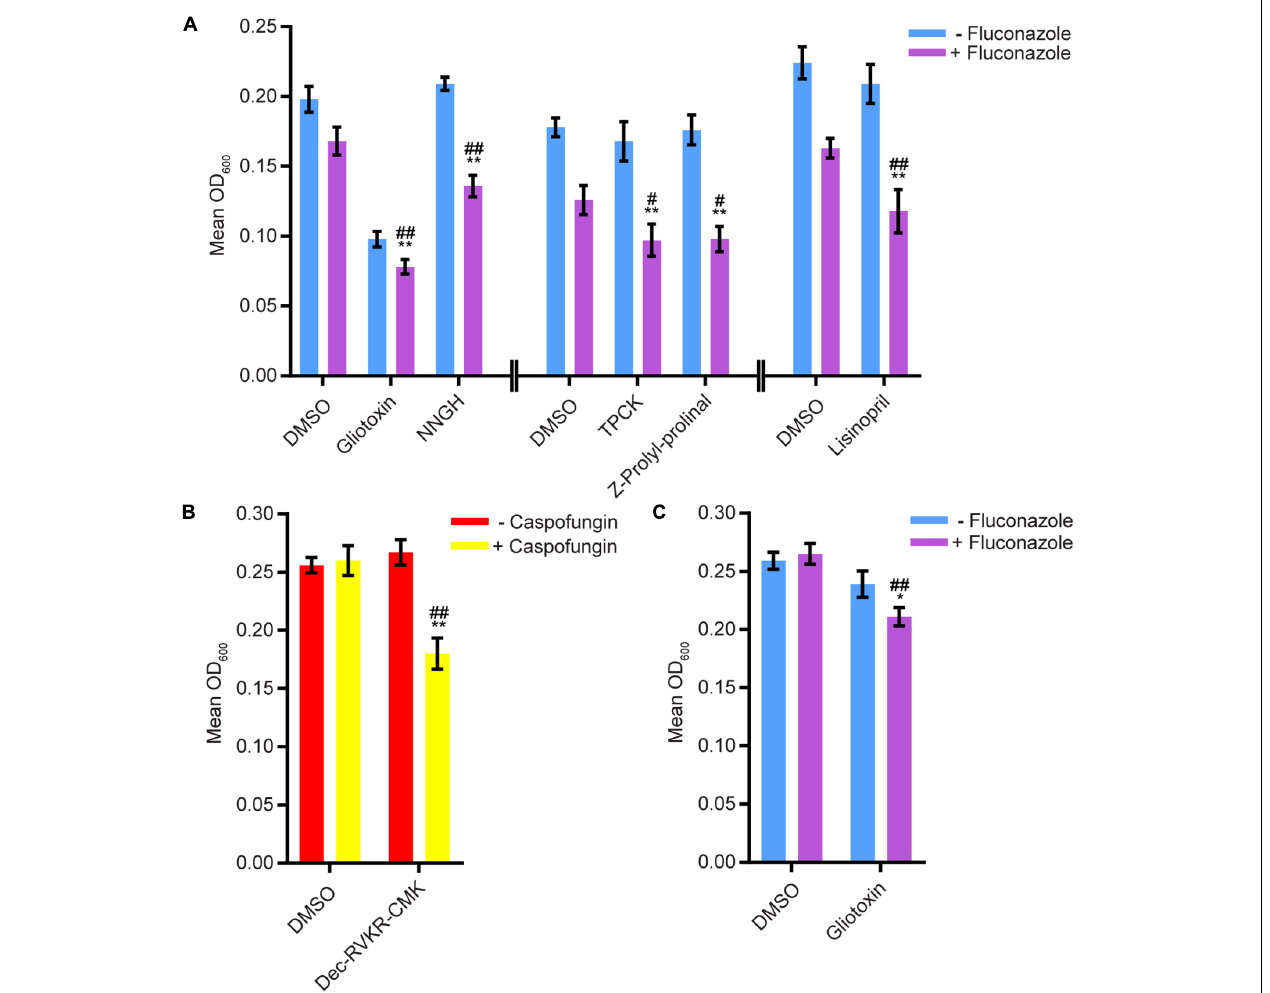
FIGURE 2 | Six compounds from the SCREEN-WELL R (cid:13) Protease Inhibitor Library either inhibited biofilm formation or disrupted mature biofilms in combination with one or more antifungal agents. (A) Statistically significant hits from the combination Sustained Inhibition Biofilm Assays with fluconazole. For each compound, the wells with fluconazole (+fluconazole) are indicated in purple and the wells without fluconazole (–fluconazole) are indicated in blue. (B) Statistically significant hits from the combination Disruption Biofilm Assays with caspofungin. For each compound, the wells with caspofungin (+caspofungin) are indicated in yellow and the wells without caspofungin (–caspofungin) are indicated in red. (C) Statistically significant hits from the combination Disruption Biofilm Assays with fluconazole. For each compound, the wells with fluconazole (+fluconazole) are indicated in purple and the wells without fluconazole (–fluconazole) are indicated in blue. For panels a–c, mean OD 600 readings with standard deviations are shown; significant differences from the compound without antifungal agent control (e.g., gliotoxin, – fluconazole), as determined by Welch’s t -test (two-tailed, assuming unequal variance) with the Bonferroni Correction, are indicated for α = 0.05 (*) and α = 0.01 (**). Significant differences from the antifungal agent without compound control (e.g., DMSO, +fluconazole), as determined by Welch’s t -test (two-tailed, assuming unequal variance) with the Bonferroni Correction, are indicated for α = 0.05 (#) and α = 0.01 (##). Data from separate plates are separated by two vertical lines on the x -axis; the DMSO solvent control is shown for each